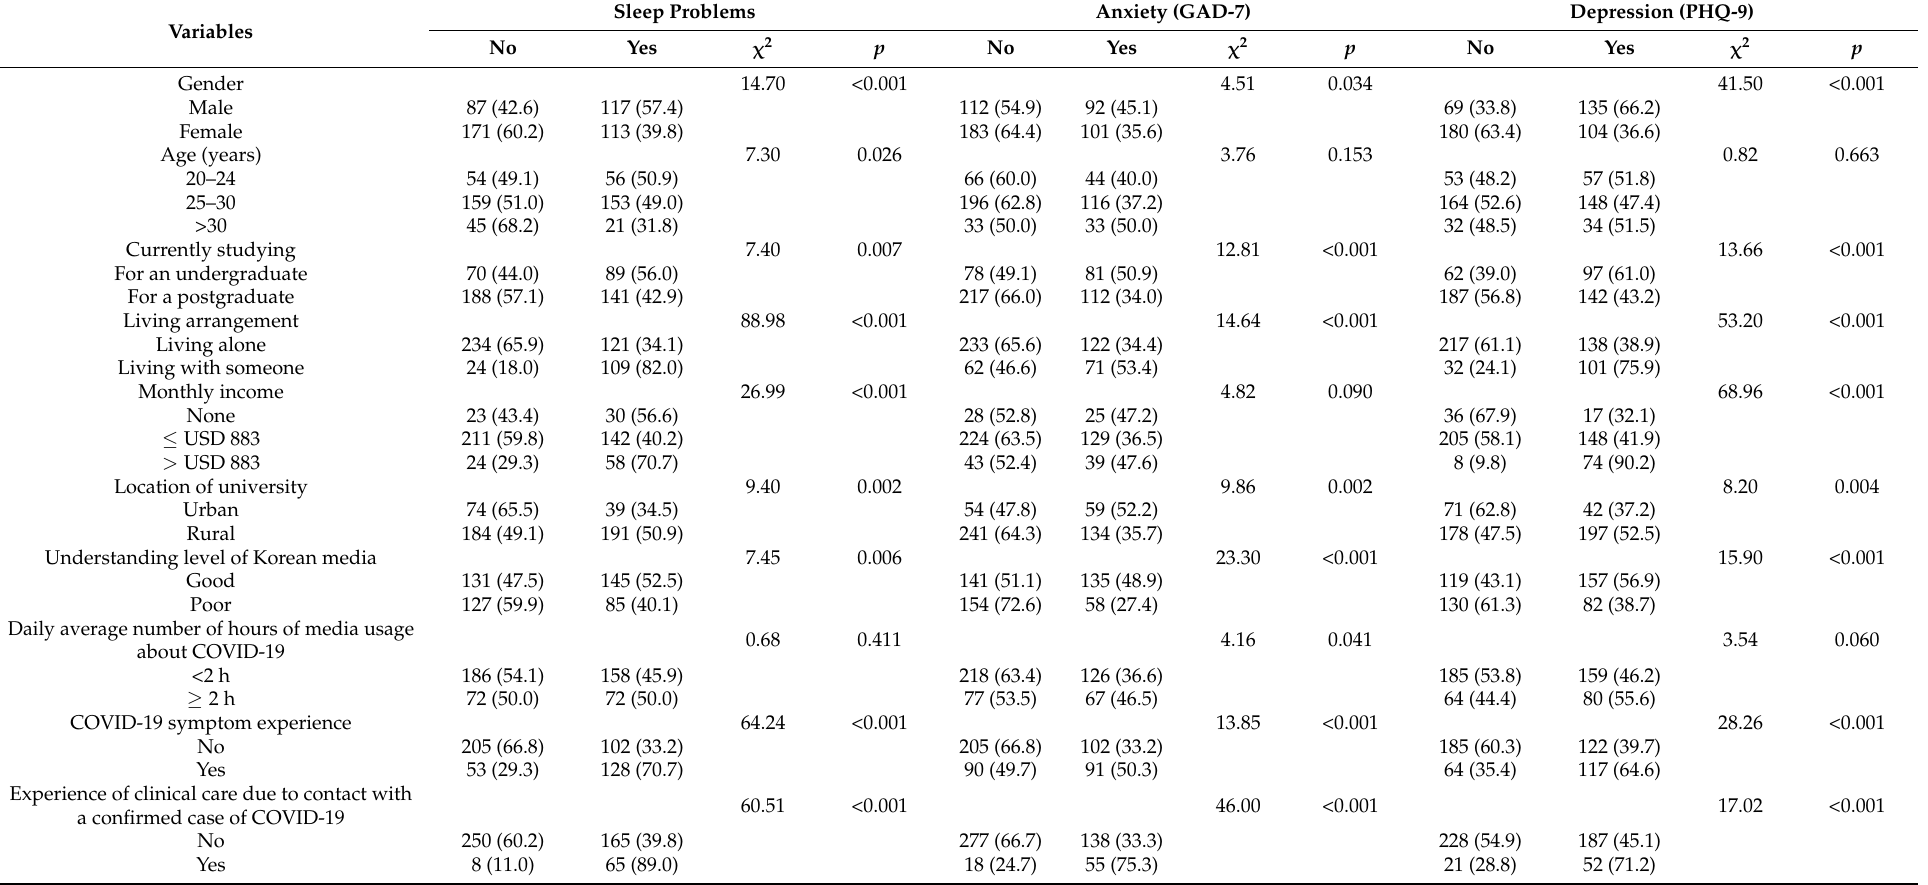
Table 3. Bivariate analyses comparing sociodemographic characteristics and mental health ( N =